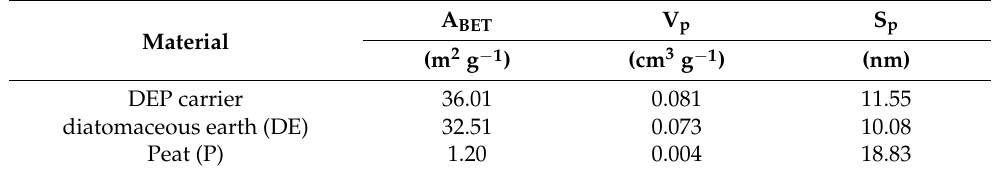
Table 3. Porous structure properties of DEP carrier, diatomaceous earth, and peat.